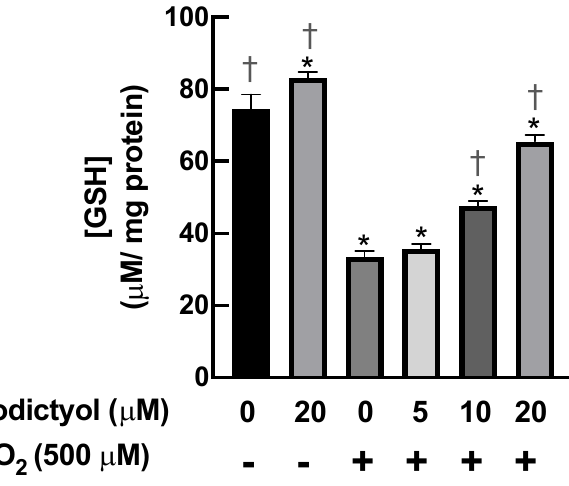
Figure 4. Eriodictyol restored the intracellular levels of reduced glutathione following H 2 O 2 exposure. H 2 O 2 (500 µ M; 1 h) rapidly decreased the availability of GSH in BJ cells. Eriodictyol pretreatment (10–20 µ M; 24 h) maintained the intracellular levels of GSH in a concentration-dependent fashion. DMSO (0.5%) was used as a vehicle control ( n = 3; each biological replicate consisted of three independent wells; mean ± SEM). * p < 0.05 versus vehicle controls; † p < 0.05 versus H 2 O 2 -treated cells.